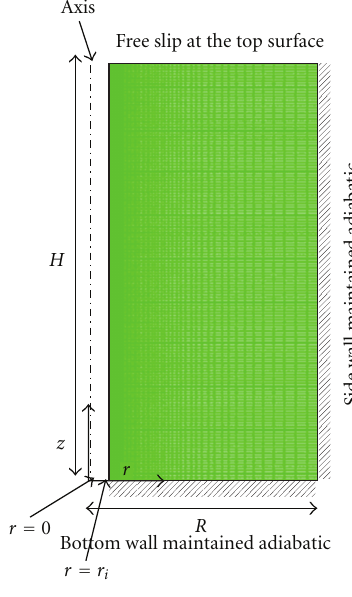
Figure 2: Sample grid of two dimensional (2D) cylindrical tank with left-hand wall